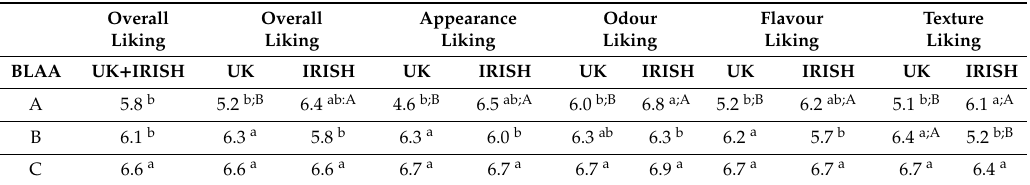
Table 2. Mean consumer liking of three Waterford Blaas for UK and Irish consumers. Data analysed using ANOVA with Tukey’s post hoc